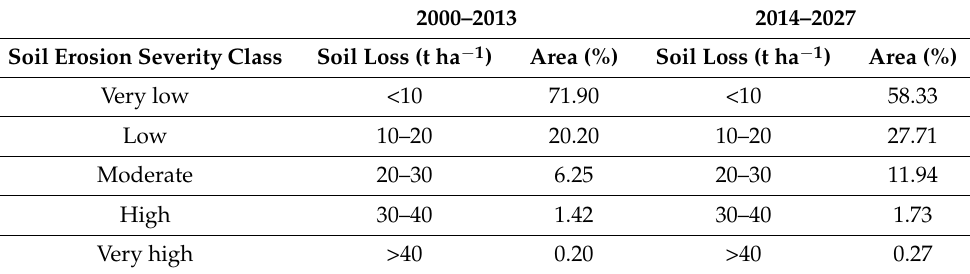
Table 7. Soil erosion classes with area occupied using SWAT model.